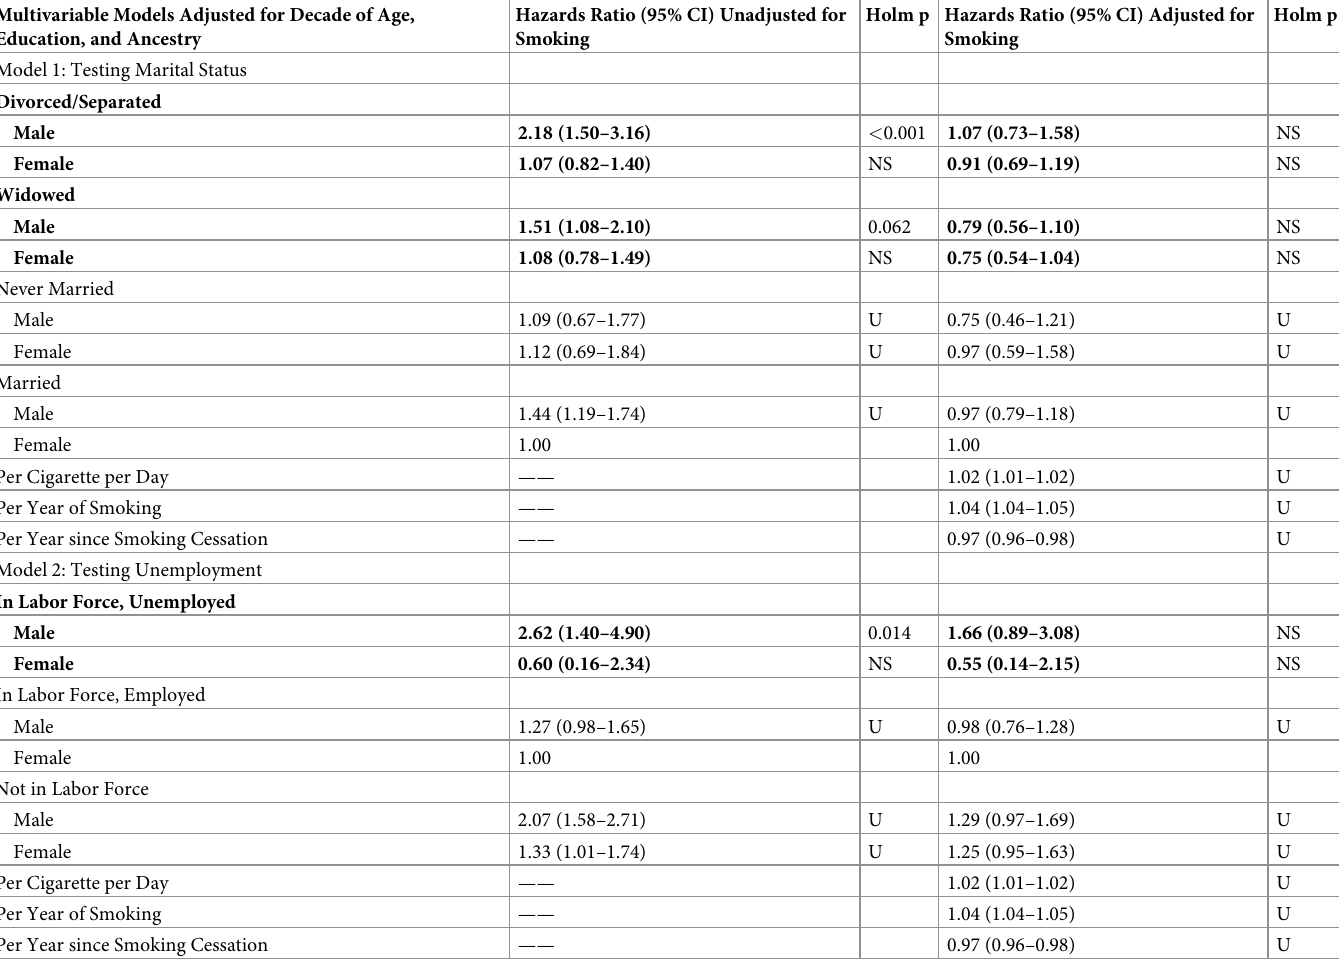
Table 2. Sex-Specific associations between marital status, unemployment, and incident lung cancer. Multivariable Models Adjusted for Decade of Age, Education, and